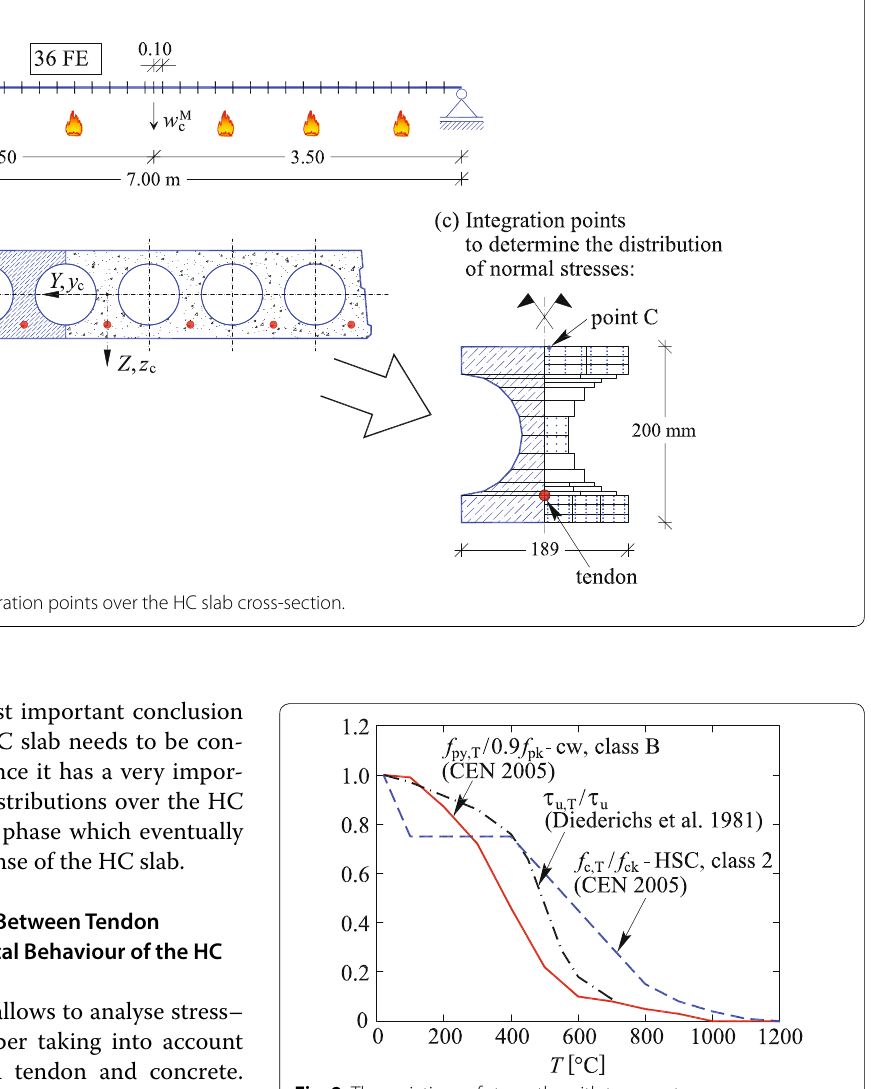
Fig. 9 The variations of strengths with